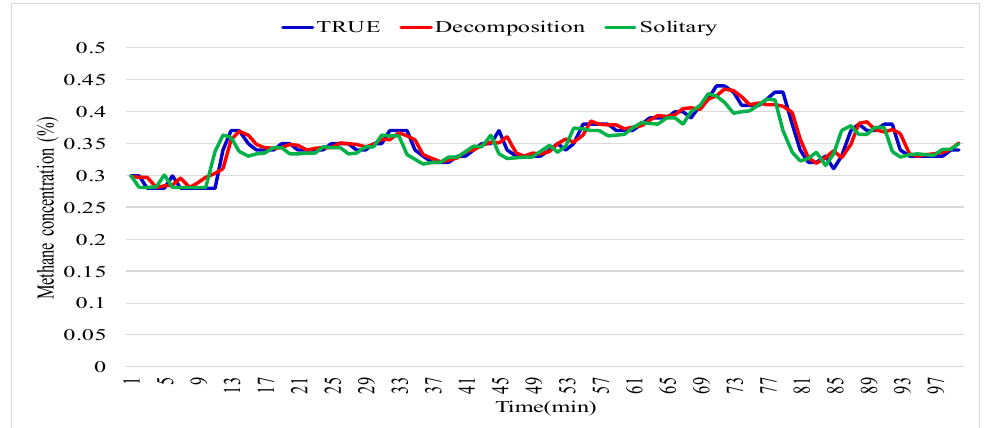
Figure 8. Comparison between methane concentration predictions obtained using decomposition and direct prediction methods.